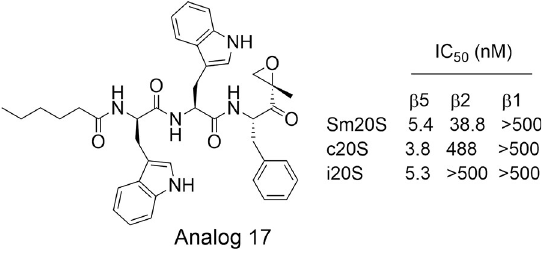
Fig 6. Inhibitor of